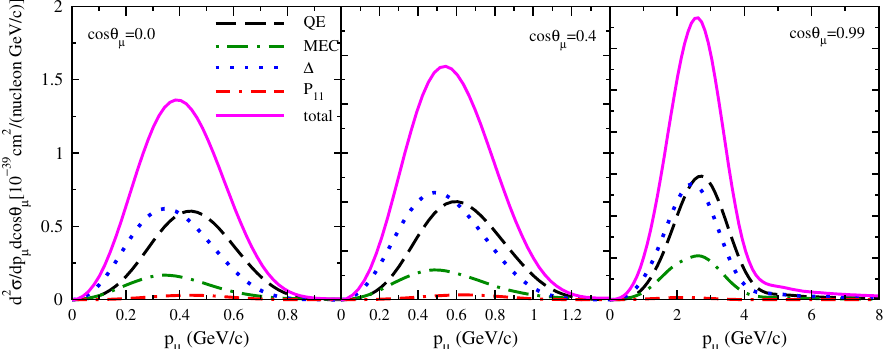
Figure 7. The SuSA predictions for inclusive double differential ( ν µ , µ − ) cross-section off 40 Ar, averaged over the DuNE flux, are displayed versus the muon momentum p µ . The separate QE, MEC, ∆ and P 11 contributions are